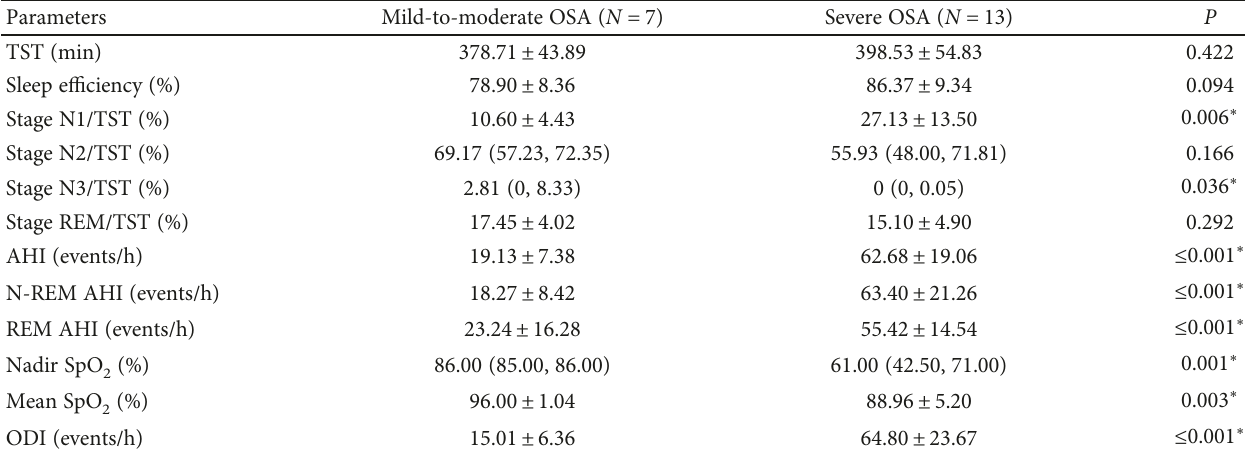
Table 4: Sleep characteristics of OSA and T2DM